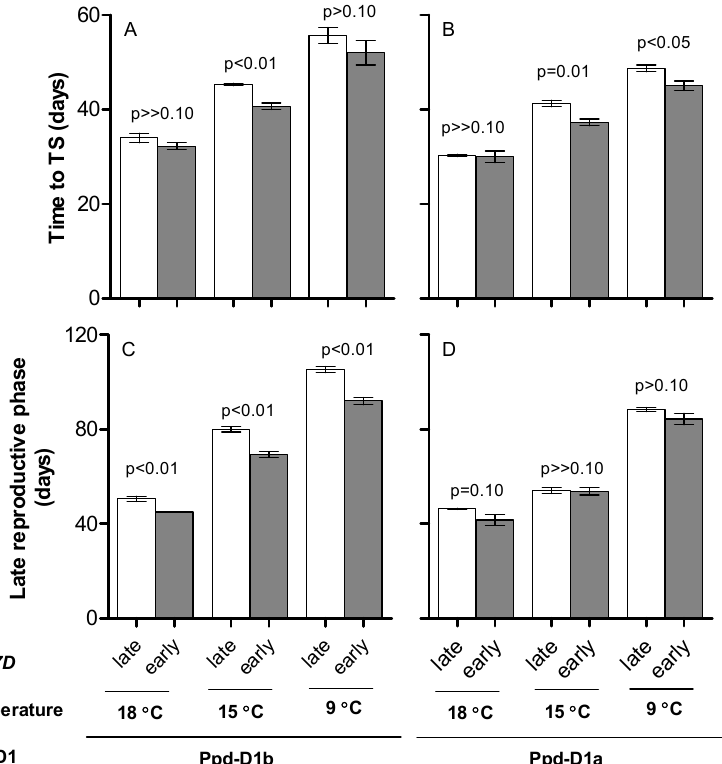
Figure 2. Duration of phase from seedling emergence to terminal spikelet (TS) ( A,B ) and time from then to anthesis, the late reproductive phase ( C,D ) for the lines carrying Eps-7D-late (open bars) or -early (closed bars) with Ppd-D1b ( A,C ) or Ppd-D1a ( B,D ) alleles in the background under short day at three growing temperatures. Error bars indicate the SEM and the p -value indicates the level of significance exclusively due to the action of the Eps-7D gene within each temperature and Ppd-D1 allelic condition.